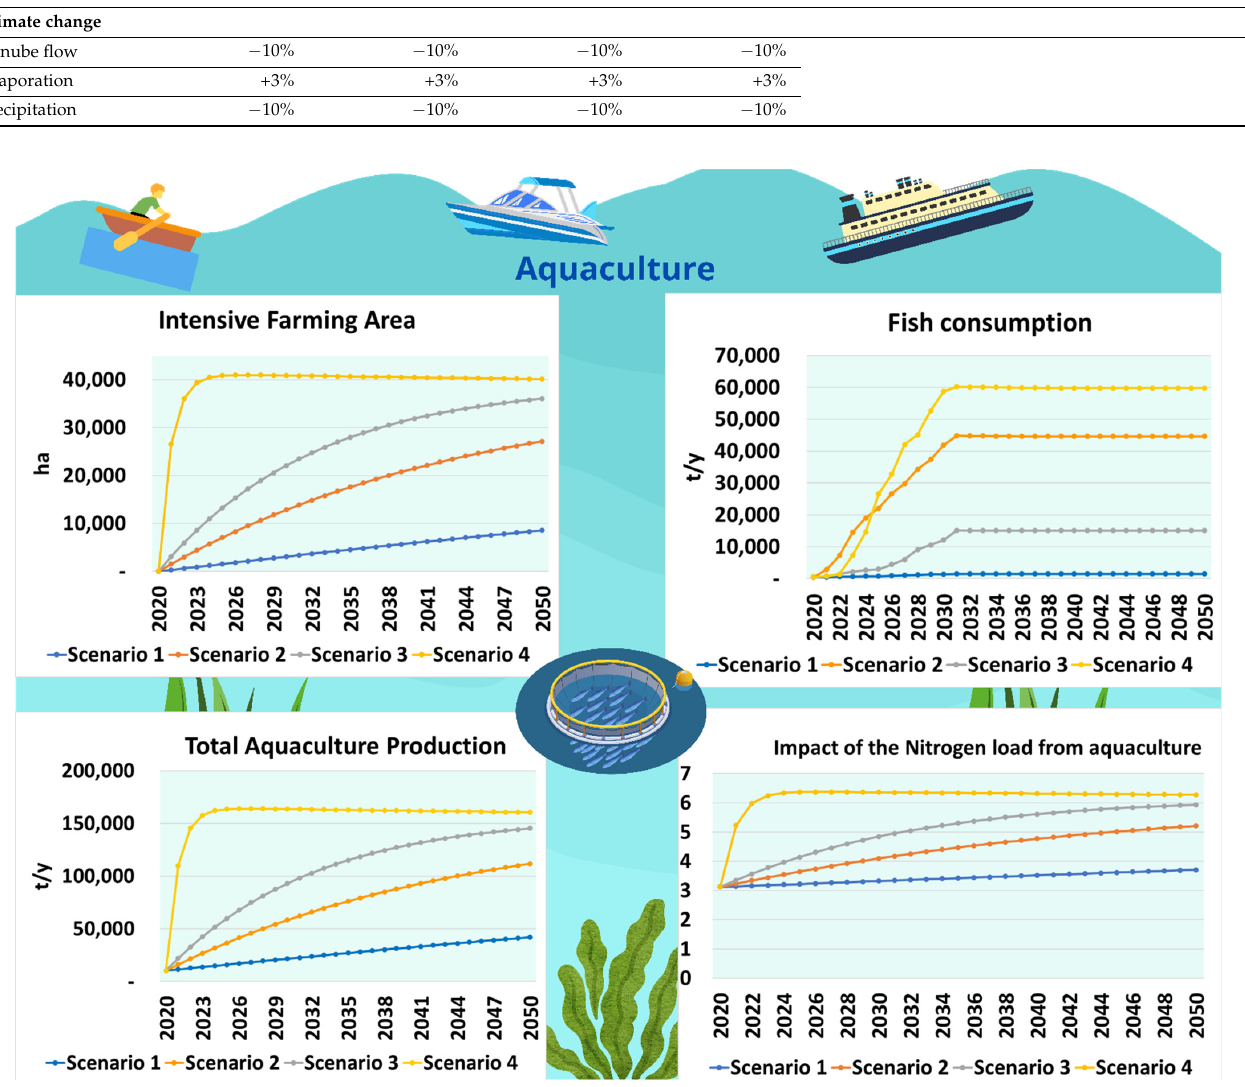
Figure 3. Aquaculture’s KPI change in different scenarios—Danube Delta.